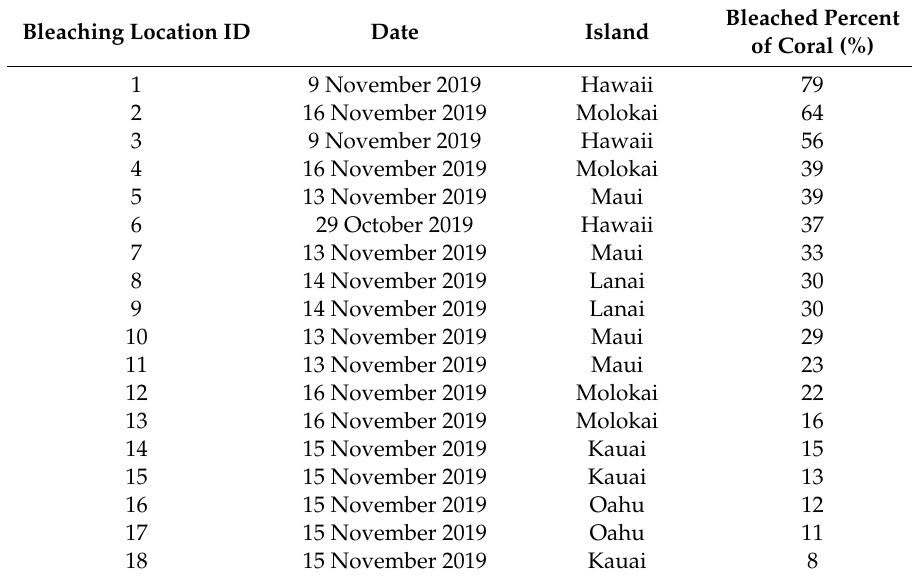
Table 1. Coral bleaching locations collected in the